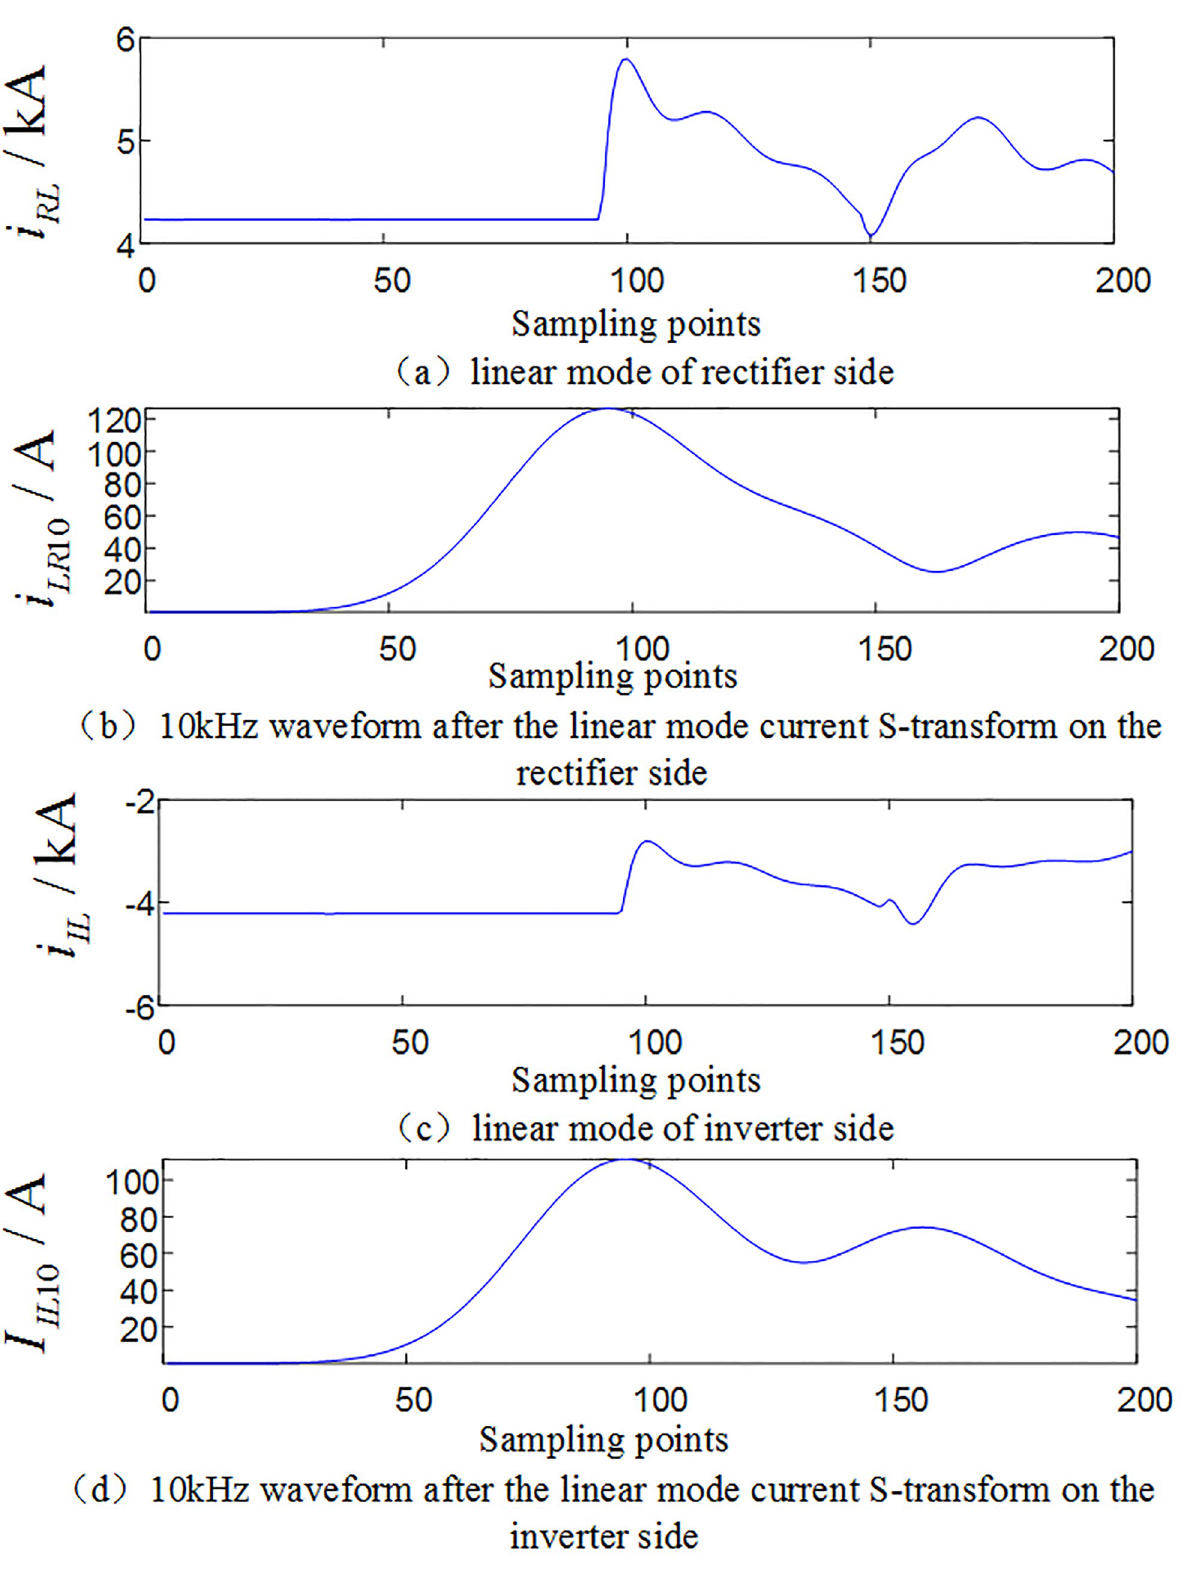
Fig 4. Related current waveforms during an internal fault occurs. https://doi.org/10.1371/journal.pone.0230717.g004 PLOS ONE | https://doi.org/10.1371/journal.pone.0230717 March 26,